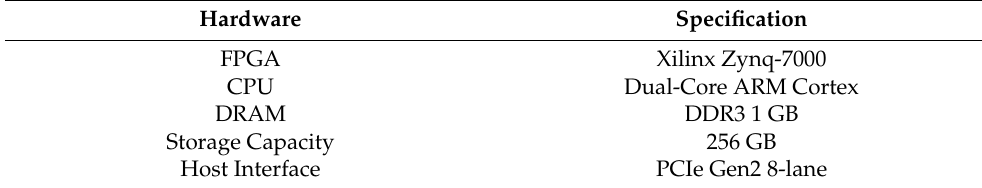
Table 1. Hardware specification of the Cosmos+ OpenSSD